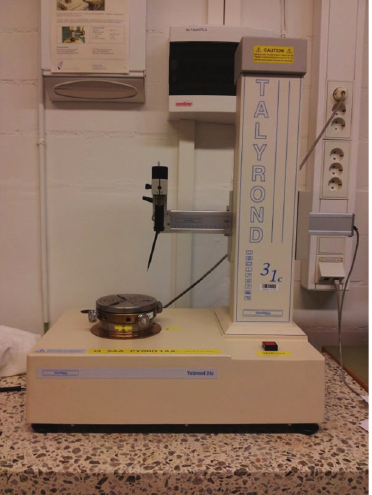
Figure 2: The out-of-roundness measurement device that was